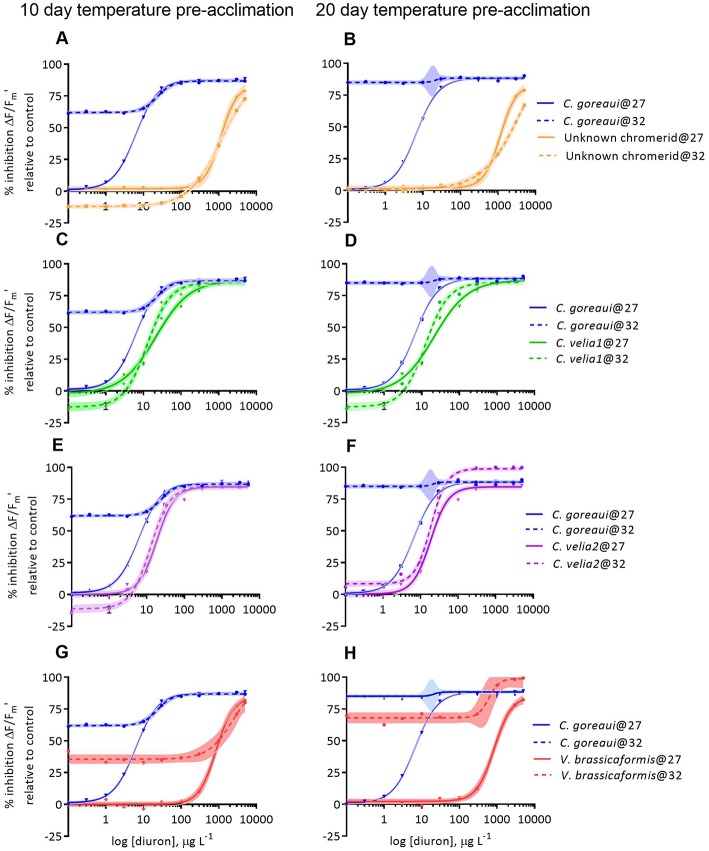
Dose-responses to diuron of the percentage inhibition of effective (ΔF/Fm′) quantum yields of Cladocopium goreaui and four strains of chromerids at 27 and 32°C, after 10 (A,C,E,G) and 20 days (B,D,F,H) of exposure to each temperature before being exposed to diuron for 48 h and thus spending a total of 12 and 22 days exposed to the different temperature conditions. Inhibition is relative to the quantum yield values at 0 ug L−1 of diuron and 27°C for each strain. Curves are fitted with non-linear regressions. Shaded areas represent confidence interval (95%) bands.